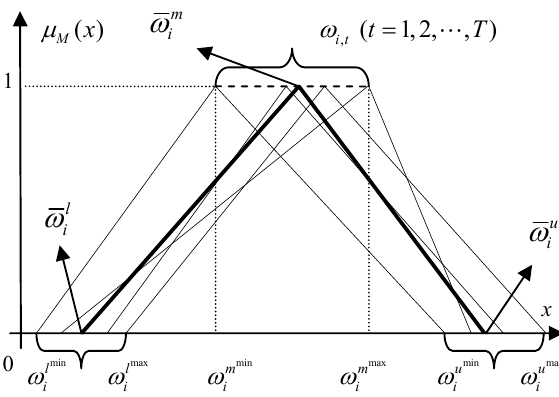
Fig. 5. One case of combining two triangular fuzzy weights from 2 experts